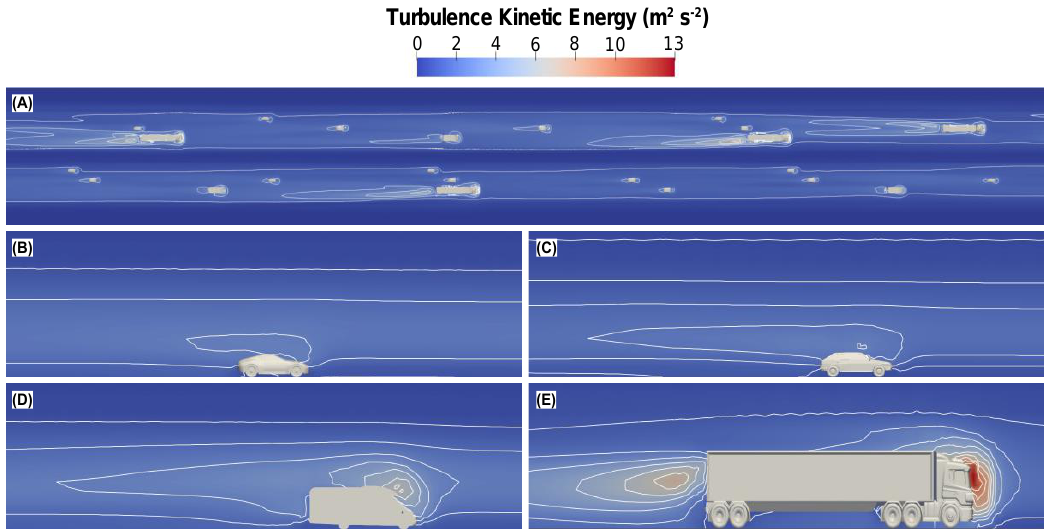
Figure 7. Turbulence kinetic energy obtained in a zero-wind flat terrain model in which all the fleet moves with a speed of 25 m/s. ( A ) Downward zoomed view from the top of the domain, ( B – E ) zoomed view from the front of the domain of the four vehicle types used in the model, which are are ( B ) sports car, ( C ) family car, ( D ) motorhome, and ( E ) heavy goods.